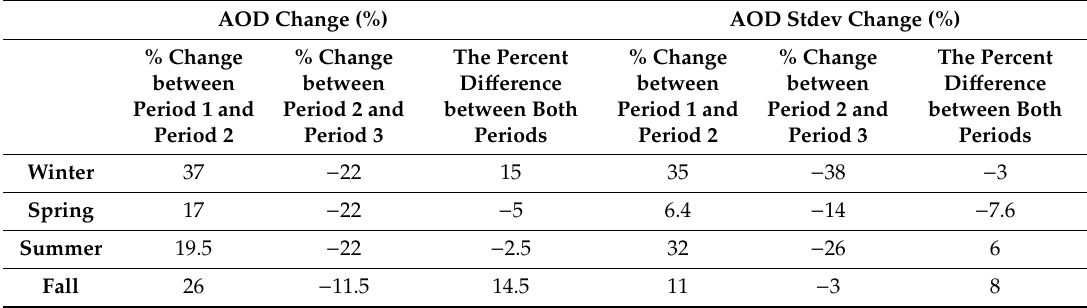
a Period 1: 1 March 2000–19 March 2003 (before OIF); Period 2: 20 March 2003–31 December 2011 (presence of US forces); Period 3: 1 January 2012–31 December 2018